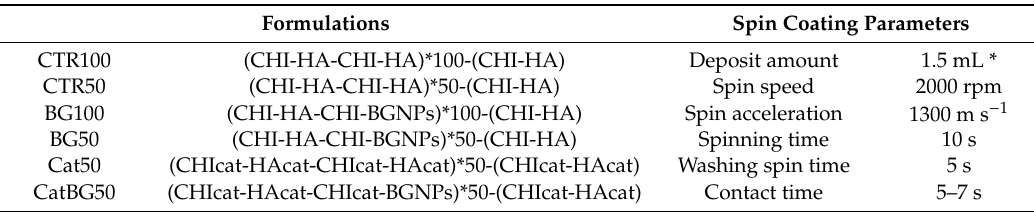
Figure 3. Schematic representation of the distinct freestanding film formulations with the chemical structure of each compound and their possible chemical interactions. Table 2. Multilayered formulations and spin-coating parameters used to assemble spin-coated layer- by-layer (LbL) freestanding films.